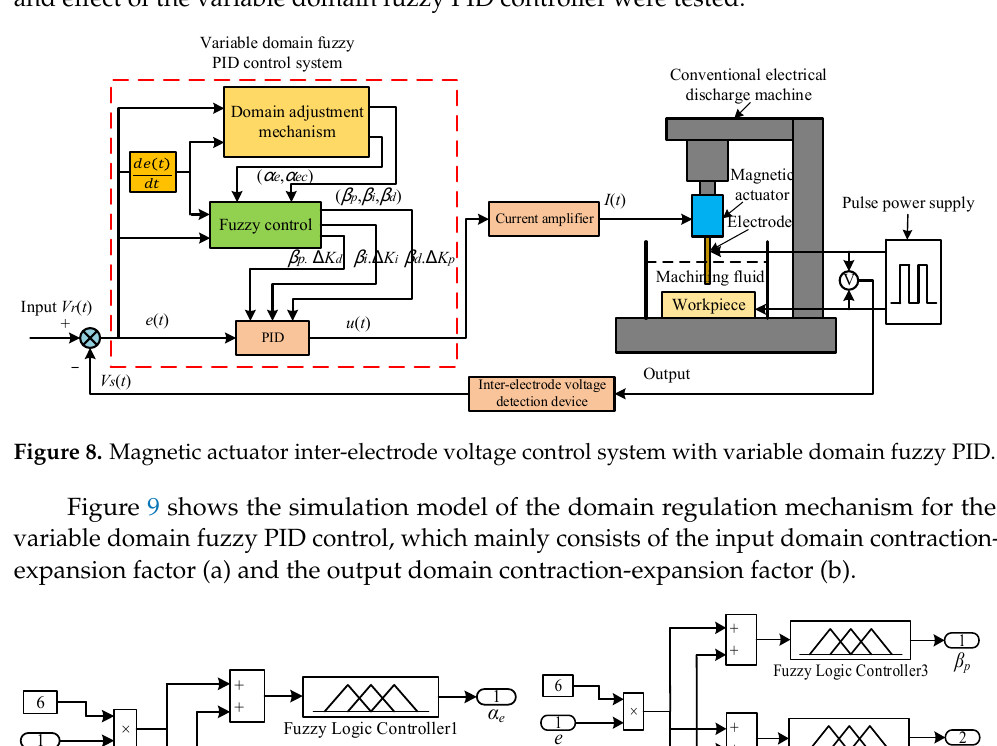
Figure 10. Simulation curve of inter-electrode voltage control of the magnetic actuator for micro- EDM.